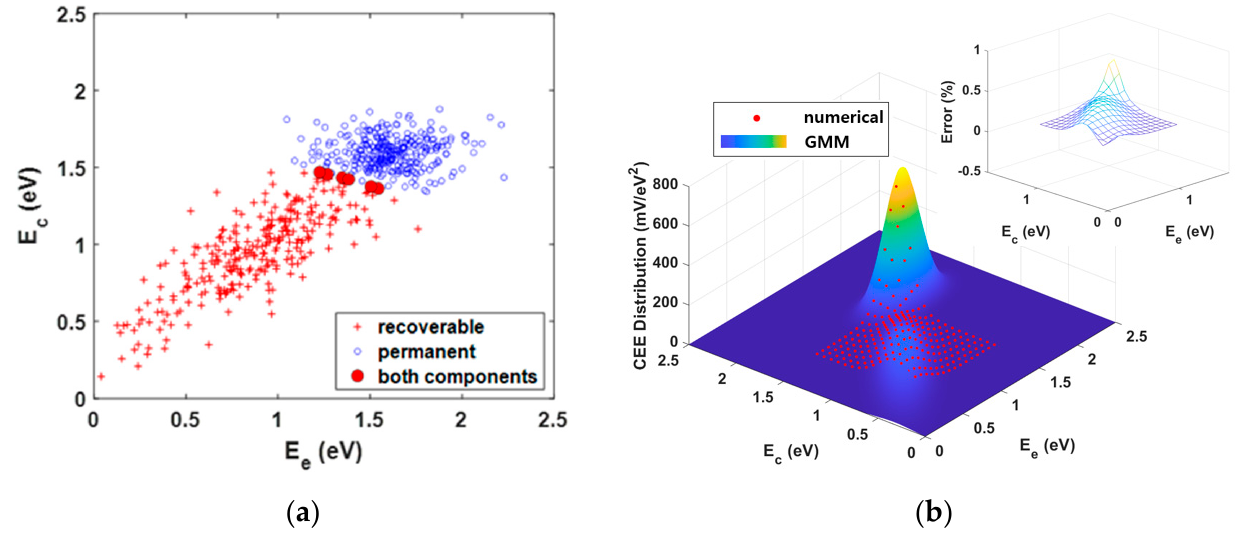
Figure 2. CEE map with fitted Gaussian mixture (GMM) using soft clustering. ( a ) Scatter plot of GMM data. ( b ) Comparison of GMM data with numerical data of CEE map.